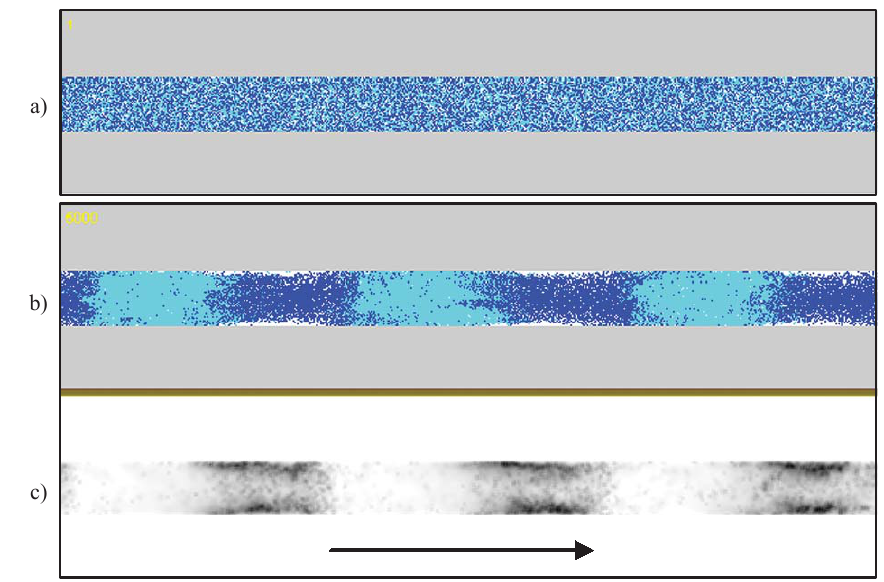
Fig. 13. Collective particle alignment and the travelling wave. a) Initial random distribution of particles and their alignments, b) When the stable travelling wave occurs particles are distributed into groups sharing similar directional alignment: lighter regions are oriented to face right and darker regions are oriented leftwards, c) Chemoattractant flux in travelling wave moving to the